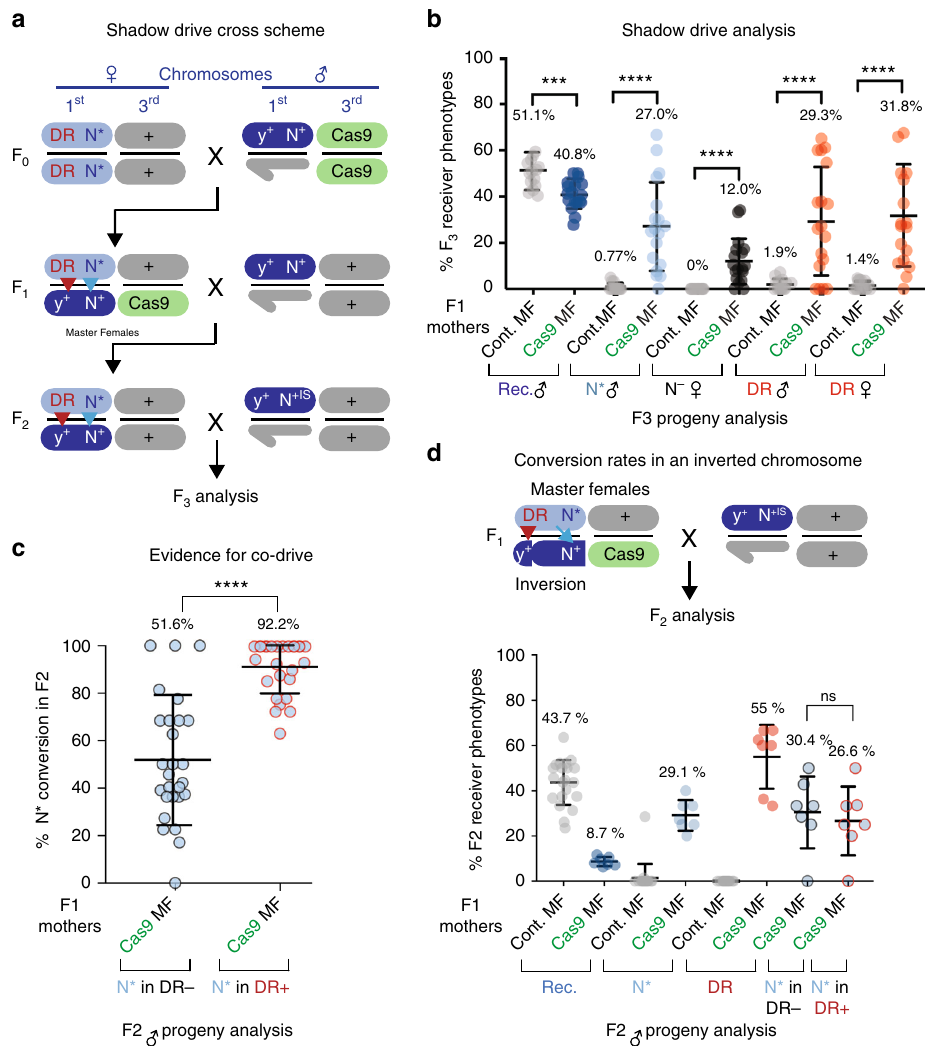
Fig. 3 Shadow-drive and co-drive analyses. a Three-generation crossing scheme for analyzing shadow-drive in the F3 generation. F2 ♀ derived from F1 master females were crossed to N + IS ♂ , and F3 progeny were scored for percentage conversion of F2 receiver chromosomes and generation of N − alleles. b Percentage of F3 progeny demonstrating features of drive including (from left to right): percentage of receiver chromosomes converted to N Ax16 allele ( N *, blue circles; presence or absence of Cas9 refers to F1 generation); percentage of heterozygous N − / + females ( N − , black circles); and percentage of individuals having copied DsRed marked y <ccN> element to receiver chromosomes in either males or females (red circles). The small percentages shown in control crosses (gray circles), in which F1 females lacked source of Cas9, presumably re fl ect the low rates of recombination between w a and N Ax16 (0.5 cm) or the y <ccN> element (1.5 cm). c Evidence for co-drive of N Ax16 ( N *) allele with DsRed (DR + ) marked y <ccN> element among individuals inheriting receiver chromosomes. d Chromosome pairing is required for ef fi cient allelic-drive and co-drive. Top panel: Genetic crossing scheme depicting allelic-drive to a balancer chromosome (Basc) that sustains approximately normal chromosome pairing for the yellow locus but not for Notch . Lower panel: Experimental results showing approximately normal levels of DsRed conversion of the Basc chromosome but signi fi cantly reduced copying (~1/3) of the N Ax16 allele. In addition, co-drive of the DsRed and N Ax16 alleles was abolished by the Basc